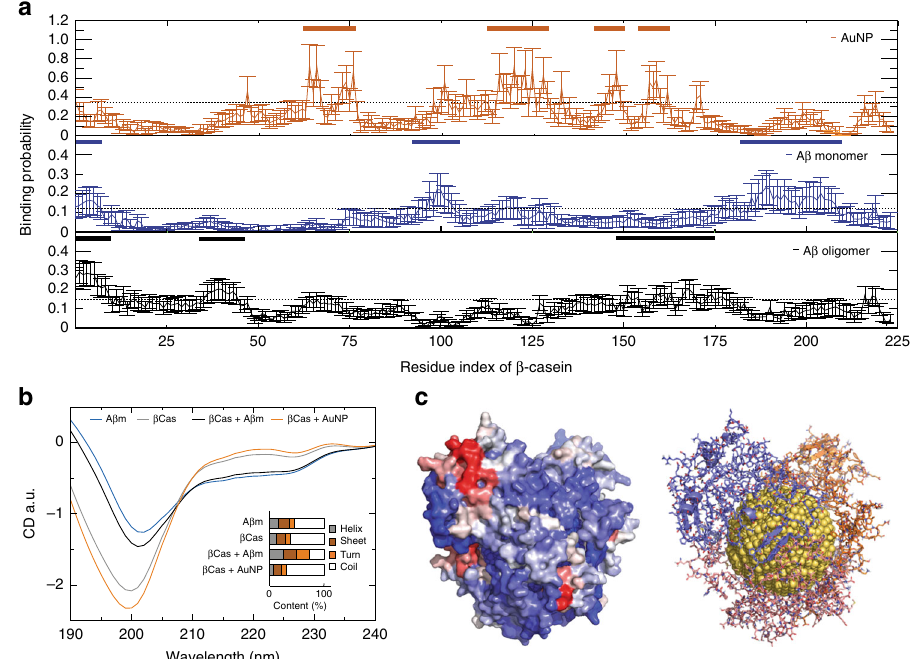
Fig. 2 DMD simulations of β Cas binding with AuNP, A β monomer, and oligomer. a Binding probabilities of β Cas with an AuNP, an A β monomer and an A β oligomer, where high-binding is de fi ned as residues with binding probabilities above one standard deviation from the average (dash lines). β Cas high- binding residue regions with AuNP and with A β monomer/oligomer are highlighted with bars (inset). b Predicted CD spectra of secondary structure contents (inset) derived from simulations. c Predicted β Cas-AuNP corona structures comprised of three β Cas proteins on an AuNP surface (right) and corresponding molecular surfaces of the proteins (left) are shown to highlight their binding with an A β monomer, where each β Cas residue was colored from purple (low) to red (high) according to its binding probability with A β monomer as in panel A middle. Source data are provided as a Source Data fi